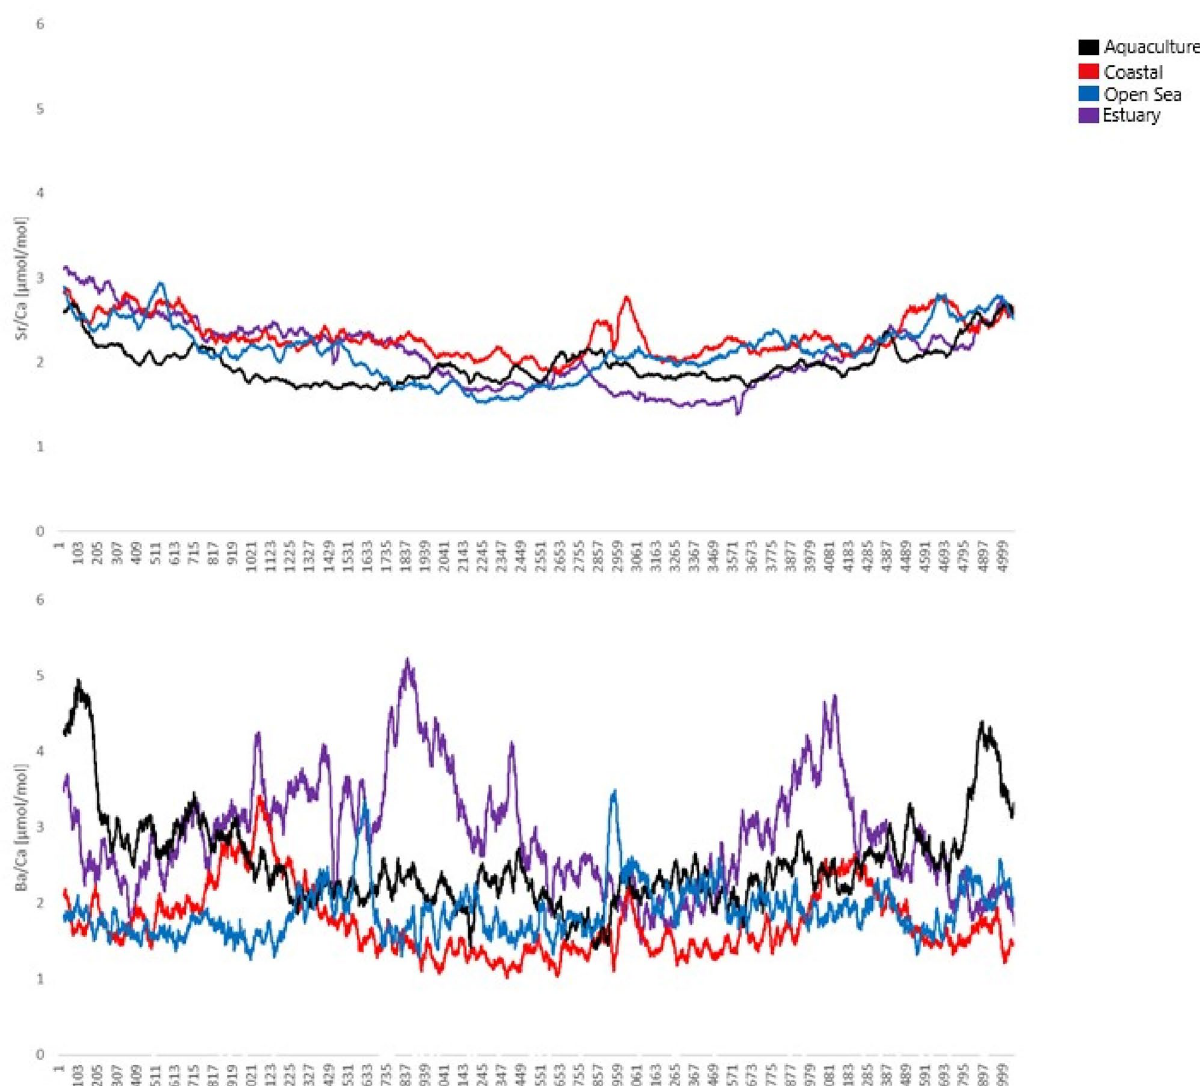
Figure 8. Box plots of median (± standard deviation) for (A) Sr/Ca; (B) Ba/Ca and Sr/Ca (C) and Ba/Ca (E) data series for all analyzed Sparus aurata specimens for 4 groups of interest: A—aquaculture, B—coastal area, C—open sea and E—estuary. Sampling conducted through the otolith core, along the axis of maximal growth. Results are displayed as 31-pt arithmetic running averages